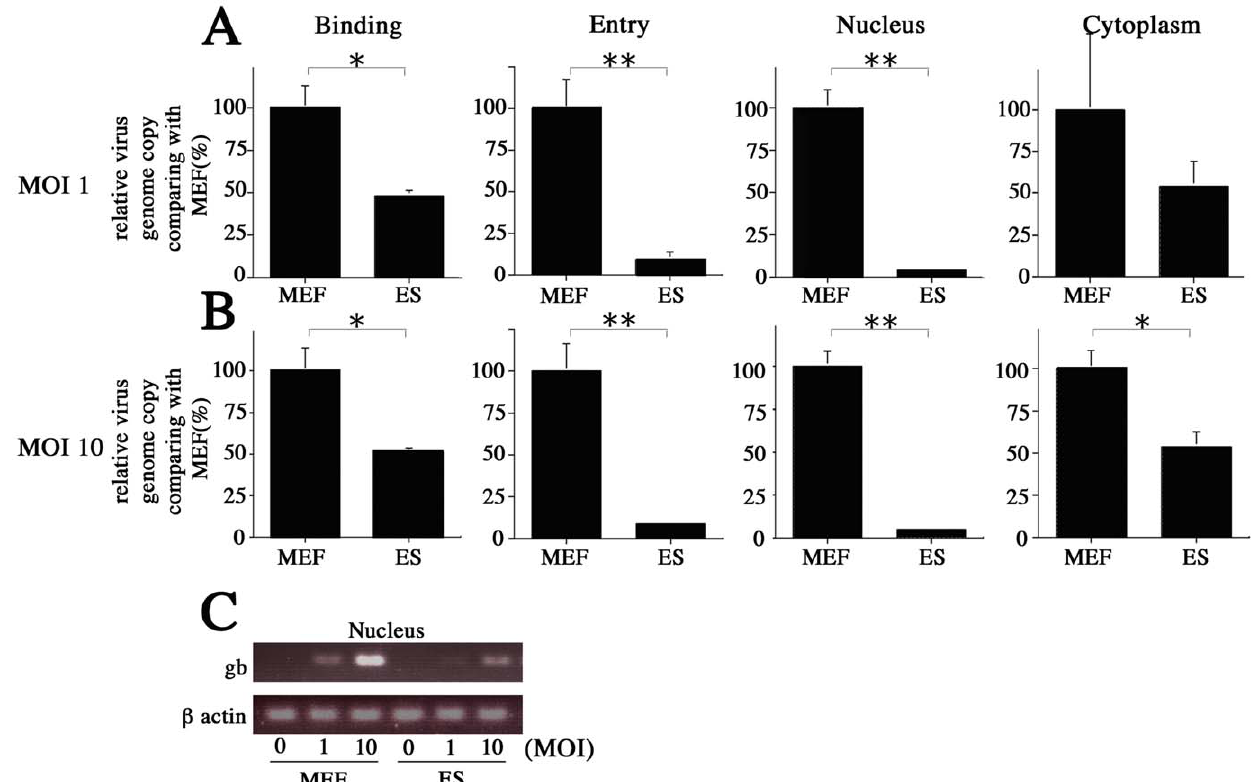
Figure 7. Comparison of MCMV infection inhibition at each stage of the infection process in MEF and ES cells. The amount of MCMV DNA was quantified at the binding and entry stages and in the nucleus and cytoplasm of MEF and ES cells infected with MCMV at MOIs of (A) 1 and (B) 10. (C) Results from semi-quantitative PCR used to measure the amount of MCMV DNA in the nuclei of MEF and ES cells. All presented experiments were performed at least 3 times, and data are given as the mean 6 SD. * P , 0.05, ** P , 0.01, t- test.